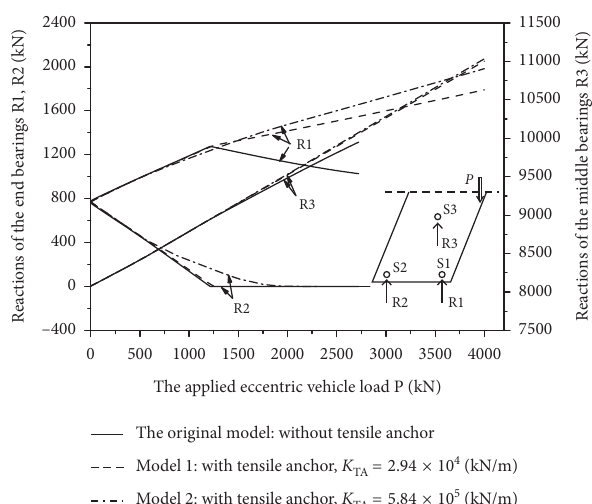
Figure 17: Applied load-vertical reactions’ relationships calculated from the models with and without tensile anchors.